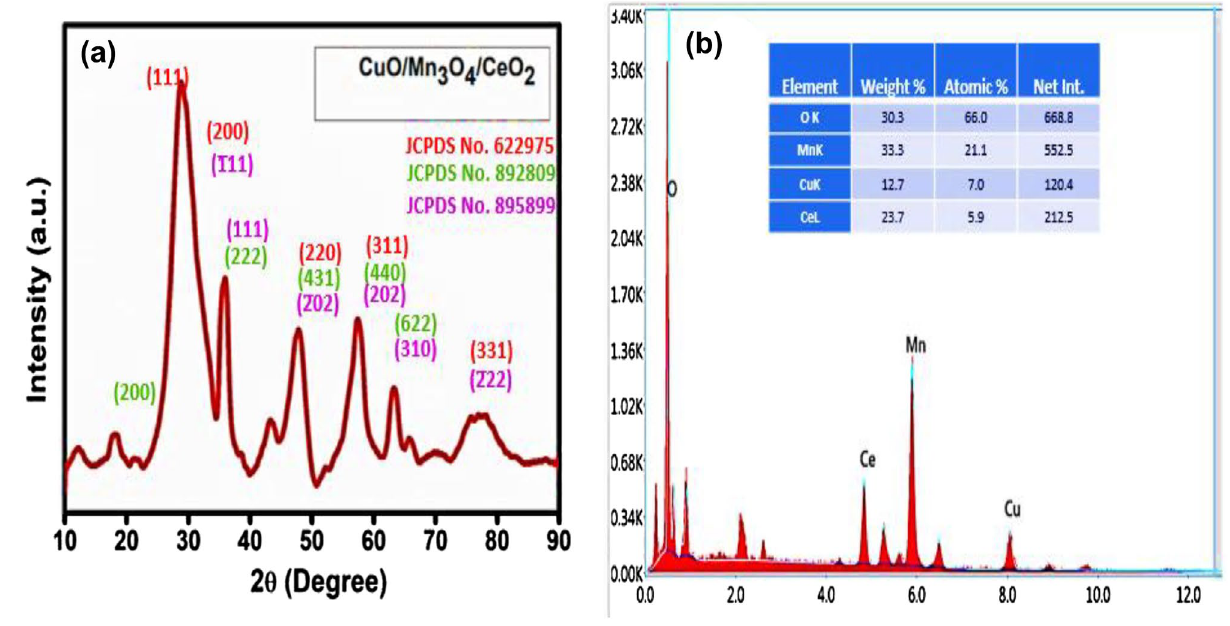
Figure 14. ( a ) PXRD and ( b ) EDAX spectrum of photocatalyst CuO/Mn 3 O 4 /CeO 2 after the run of the fourth cycle for MG dye